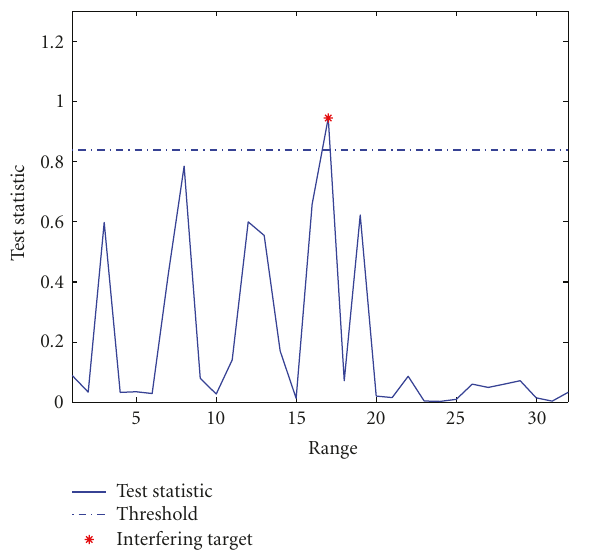
N it = 1 Automatic Figure 13: P r versus INR. Data from file 19980204 − 220849, with = 0 . 025, and ni = 1. N = 8, K = 24, P e 0